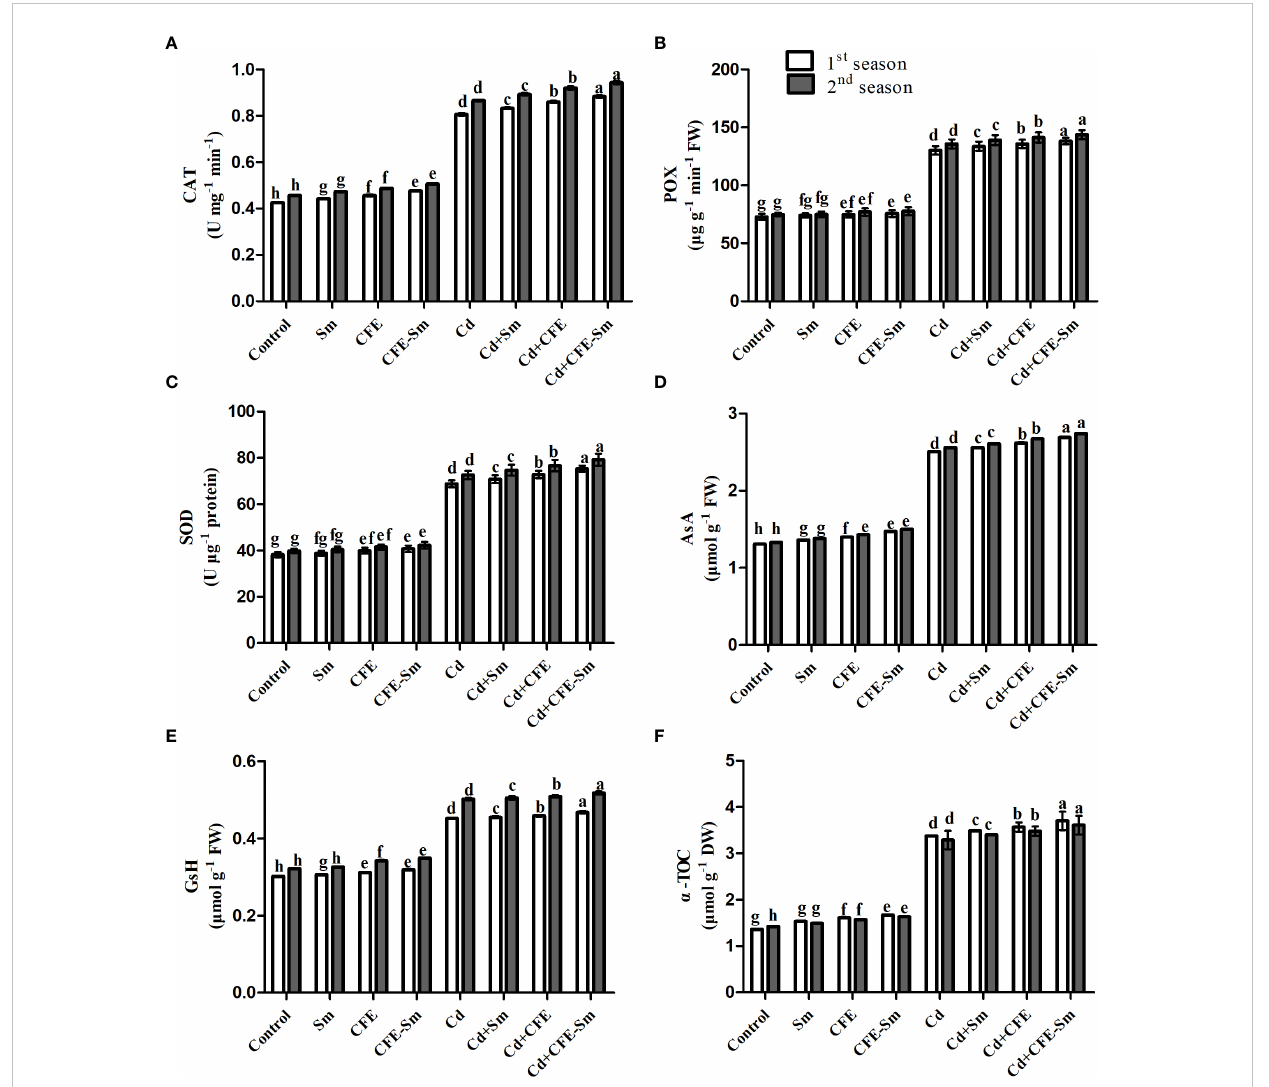
FIGURE 3 Impacts of silymarin (Sm), clove fruit extract (CFE), or silymarin-enriched clove fruit extract (CFE-Sm) foliar application on antioxidant enzymes (A) catalase; CAT, peroxidase; (B) POX, superoxide dismutase; (C) SOD and ascorbate peroxidase), (D) ascorbate (AsA), (E) glutathione (GSH), and (F) Tocopherol (-TOC) in wheat under Cd